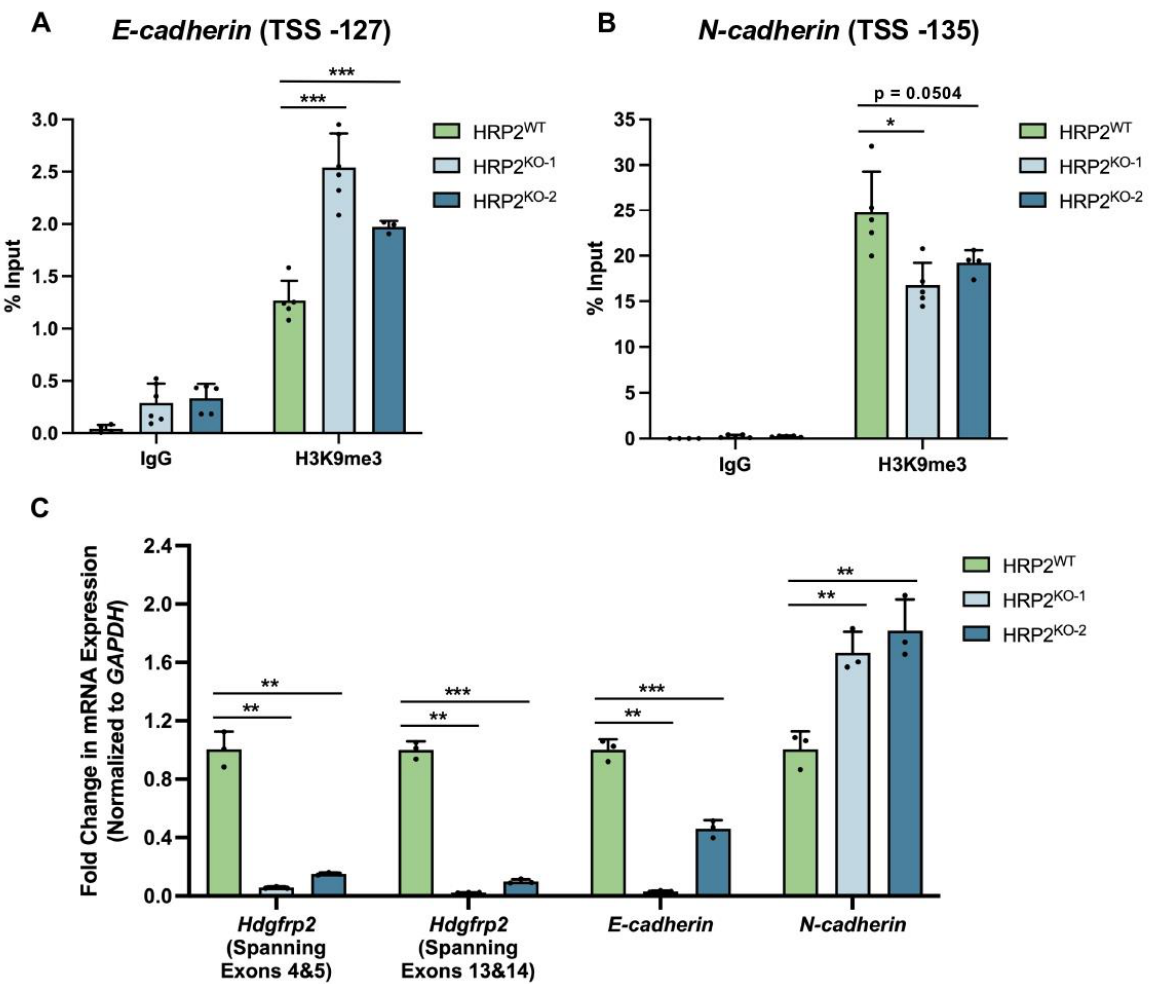
Figure 5. HRP2 knockout in MDA-MB-231 cells impacts H3K9me3 occupancy at E- and N- cadherin , resulting in altered transcriptional activity. ( A ) ChIP-qPCR analysis comparing enrichment of H3K9me3 at the E-cadherin promoter in HRP2 wildtype and knockout cells. H3K9me3 enrichment levels, measured as a percentage of input, are as follows: HRP2 WT = 1.3 ± 0.2; HRP2 KO − 1 = 2.5 ± 0.3; HRP2 KO − 2 = 2.0 ± 0.1. ( B ) ChIP-qPCR analysis comparing enrichment of H3K9me3 at the N-cadherin promoter in HRP2 wildtype and knockout cells. H3K9me3 enrichment levels, measured as a percentage of input: HRP2 WT = 24.7 ± 4.5; HRP2 KO − 1 = 16.8 ± 2.5; HRP2 KO − 2 = 19.2 ± 1.4. TSS indicates the position (in bp) from the transcriptional start site. ( C ) Analysis of Hdgfrp2 , E-cadherin , and N-cadherin mRNA expression changes under HRP2 knockout conditions. Fold-change in Hdgfrp2 expression (spanning exons 4 and 5): HRP2 WT = 1.00 ± 0.12; HRP2 KO − 1 = 0.06 ± 0.01; HRP2 KO − 2 = 0.15 ± 0.01. Fold-change in Hdgfrp2 expression (spanning exons 13 and 14): HRP2 WT = 1.001 ± 0.058; HRP2 KO − 1 = 0.023 ± 0.002; HRP2 KO − 2 = 0.098 ± 0.015. Fold-change in E-cadherin expression: HRP2 WT = 1.002 ± 0.072; HRP2 KO − 1 = 0.031 ± 0.005; HRP2 KO − 2 = 0.461 ± 0.059. Fold-change in N-cadherin expression: HRP2 WT = 1.0 ± 0.1; HRP2 KO − 1 = 1.7 ± 0.1; HRP2 KO − 2 = 1.8 ± 0.2. Statistical significance was calculated using an unpaired t -test ( n ≥ 3; * p ≤ 0.05, ** p ≤ 0.01, *** p ≤